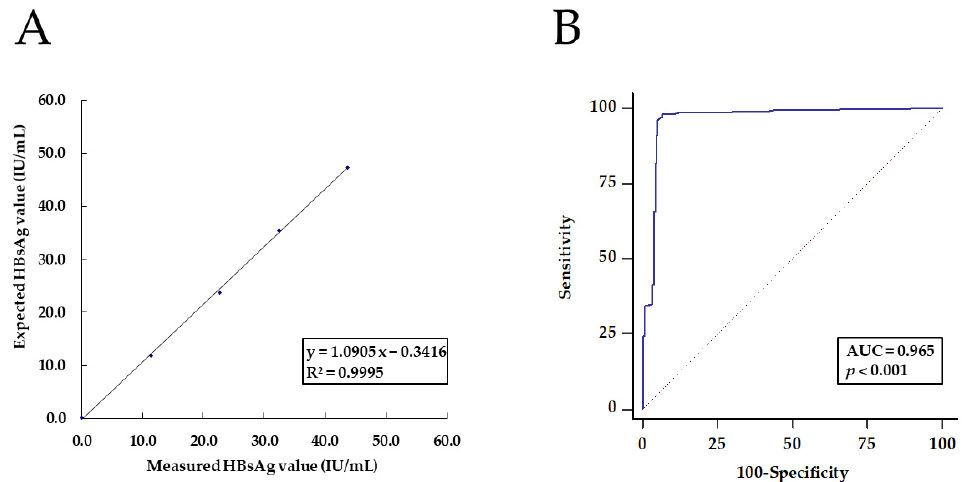
Figure 1. ( A ) Linearity analysis of the Elecsys HBsAg II Quant assay using five expected diluted assayed samples. The best-fit regression equation for the Elecsys HBsAg II Quant assay was y = 1.0905x − 0.3416. Abbreviation: HBsAg, hepatitis B surface antigen. ( B ) The receiver operating characteristic (ROC) curve analysis of the ADVIA Centaur HBsAg II assay, confirmed with the ADVIA Centaur HBsAg Confirmatory assay without further duplicate tests, shows the area under the curve to be 0.965.